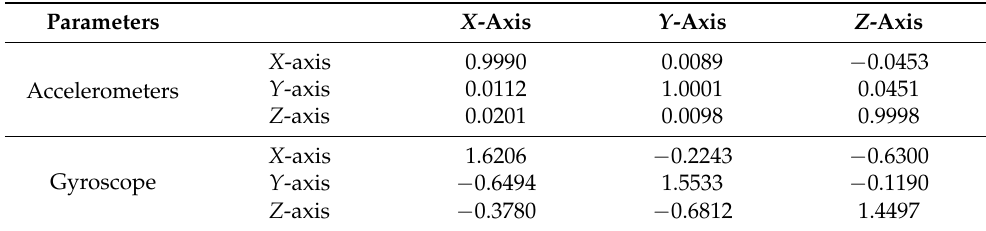
Table 6. Misalignment errors of MEMS0 accelerometer and gyro-sensitive